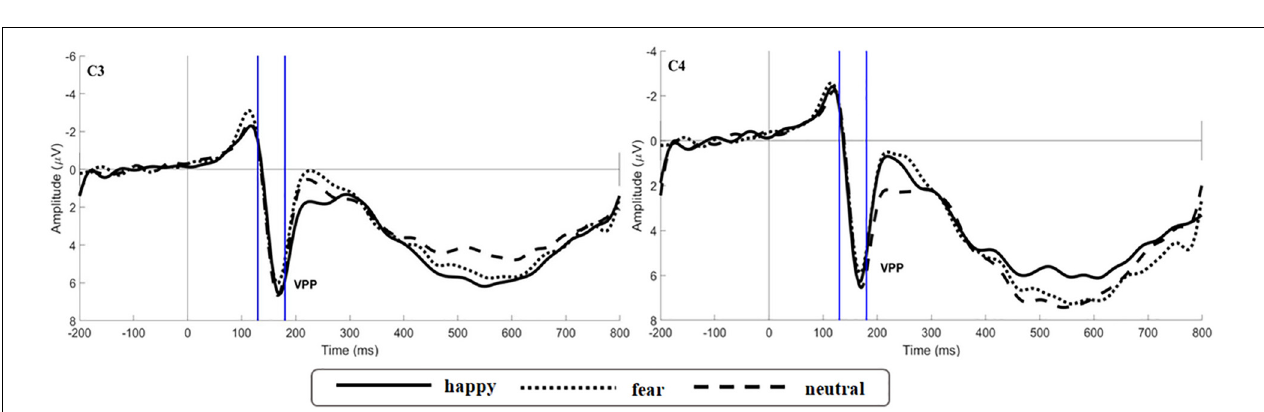
FIGURE 5 | Grand average ERP waveforms of VPP for happy, fear and neutral conditions recorded at electrodes C3 and C4.